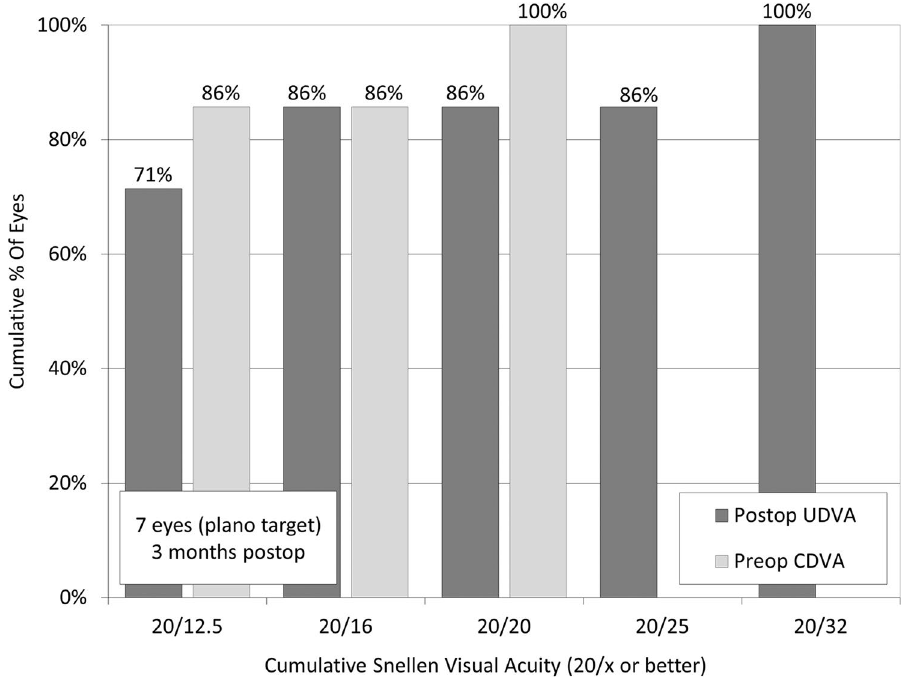
Figure 2. Cumulative percentages of eyes attaining specified cumulative levels of uncorrected distance visual acuity (UDVA) after implantable collamer lens (ICL) extraction.